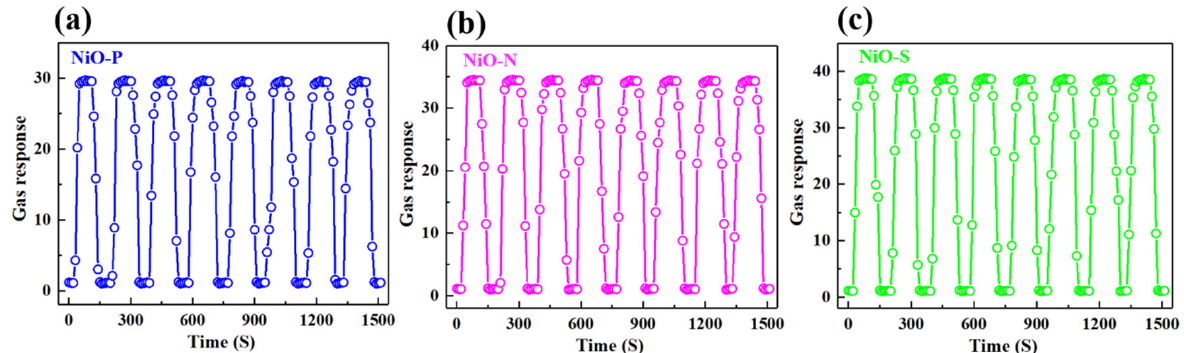
Figure 12. of ( a ) NiO-P, ( b ) NiO-N, ( c ) NiO-S at 350 °C to 200 ppm ethanol. Figure 12. Of ( a ) NiO-P, ( b ) NiO-N, ( c ) NiO-S at 350 ◦ C to 200 ppm ethanol.